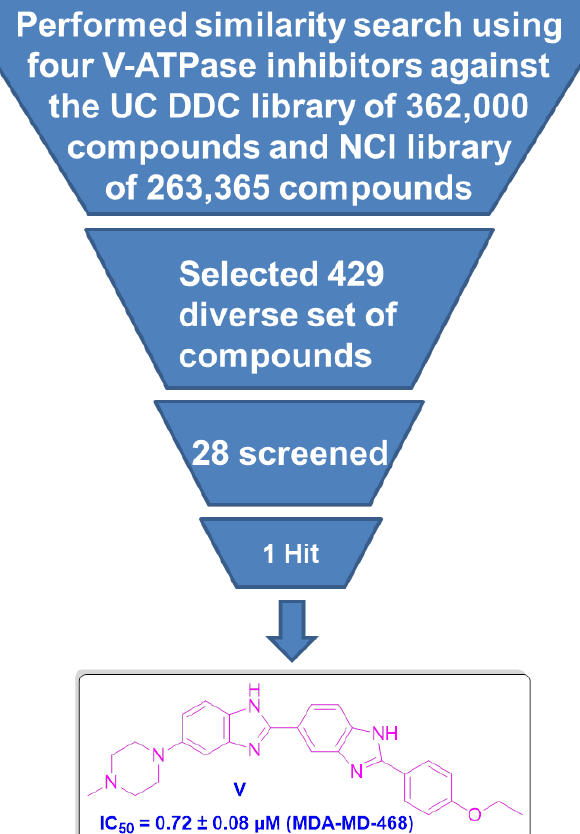
Figure 2. Identification of an initial hit by similarity search using known V-ATPase inhibitors.